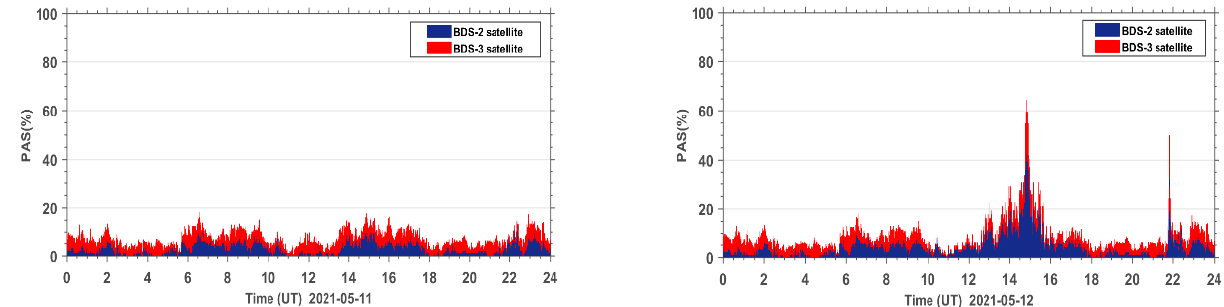
Figure 5. Time series of PAS for BDS sites worldwide during the reference day (11 May 2021) and the geomagnetic storm day (12 May 2021).